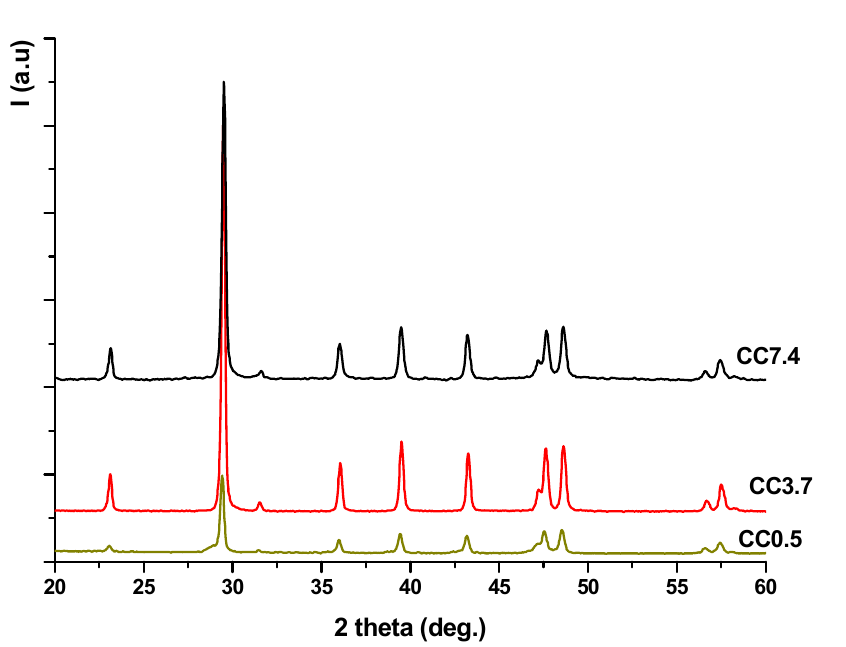
Figure 1. X-ray diffraction pattern of Portland cement ( a ), and of limestone filler ( b ). To confirm the presence of calcium carbonate in aq. susps., 1 ml from each suspension (vigorously stirred in order to be homogenous) was sampled and dried at 50 °C up to constant weight. The XRD patterns of the resulting powders (Figure 2) showed the pres- ence of a single crystalline compound—CaCO 3 (JCPDS 83-1762).